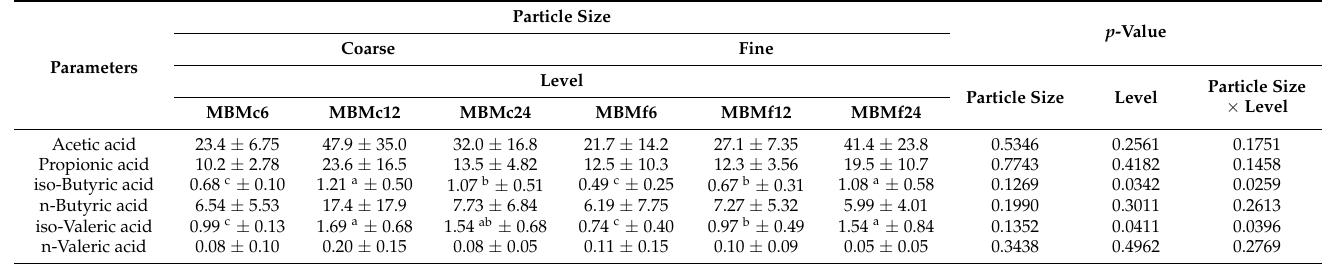
Table 4. Fatty acid profile in the feces (mmol/kg fresh feces) of dogs fed the basic diets supplemented with different levels and particle sizes of MBM (mean ±